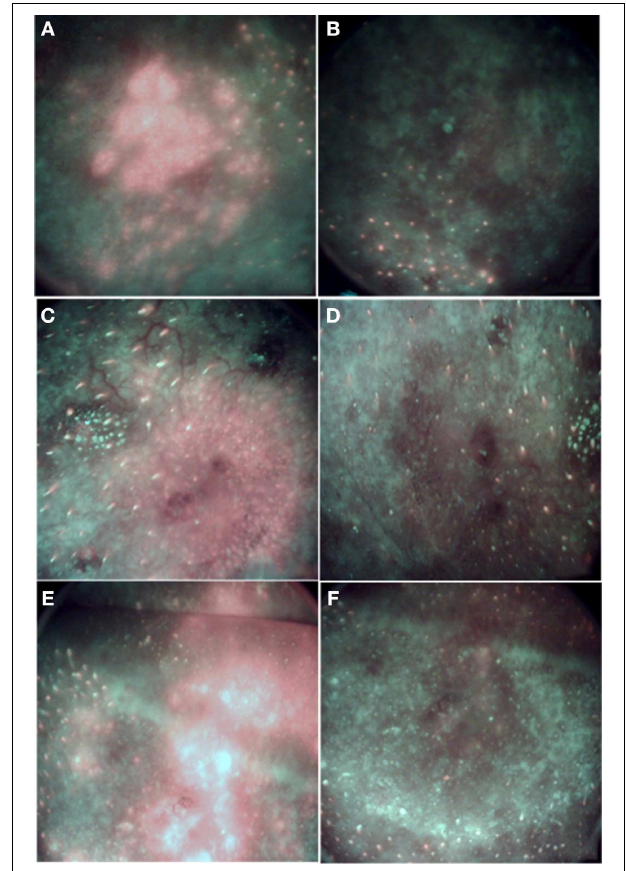
FIGURE 7 | PpIX fluorescence images of BCC lesions after 3h of MAL topical application (A,C,E) and after the first PDT session